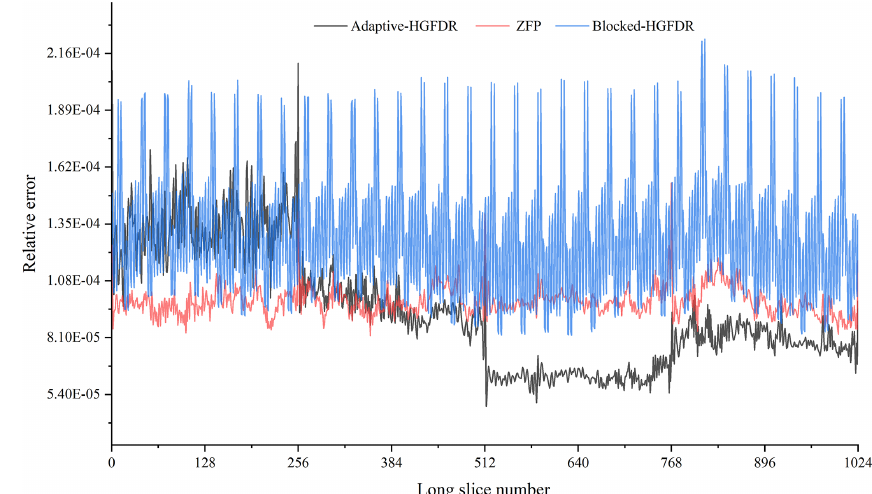
Figure 6. The distributions of compression error along the longitudinal slices (the slice means the partial data that are divided along specific dimensions).